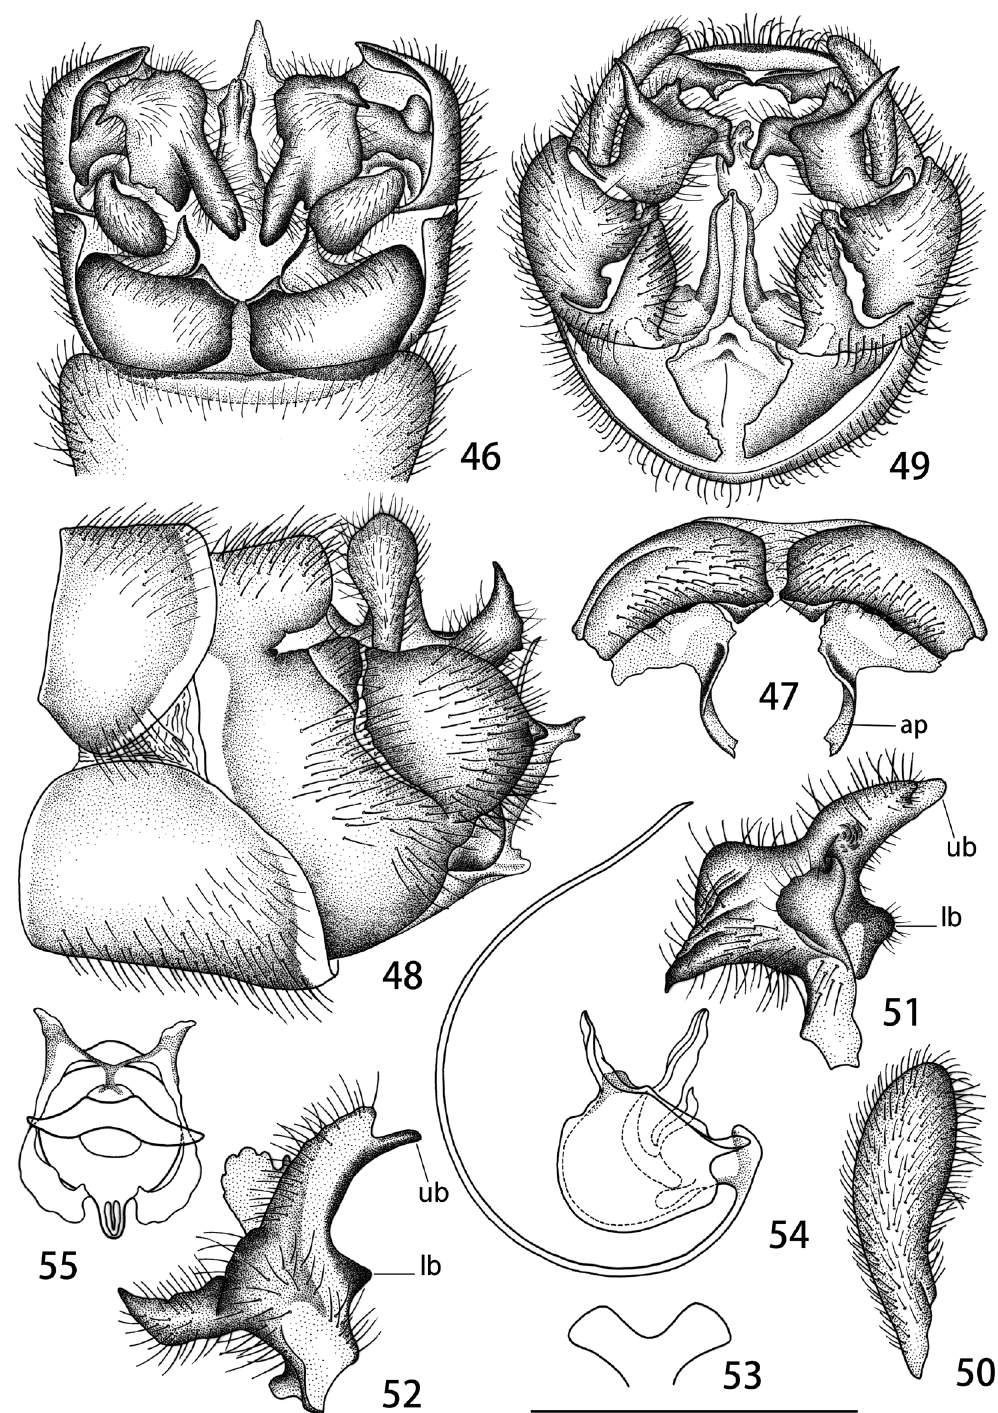
Figs 46–55. Tipula ( Vestiplex ) singularis sp. nov., ♂ , holotype (coll. Inse-YN0502). 46 . Hypopygium, dorsal view. 47 . Tergite nine, ventral view. 48 . Hypopygium, lateral view. 49 . Hypopygium, ventral view. 50 . Lobe of gonostylus. 51 . Left clasper of gonostylus, mesal view. 52 . Right clasper of gonostylus, lateral view. 53 . Ejaculatory apodeme of semen pump. 54 . Semen pump, lateral view. 55 . Semen pump, dorsal view. Abbreviations: see Material and methods. Scale bars: 46–49 = 1.0 mm; 50–52 = 0.5 mm; 53–55 = 1.2